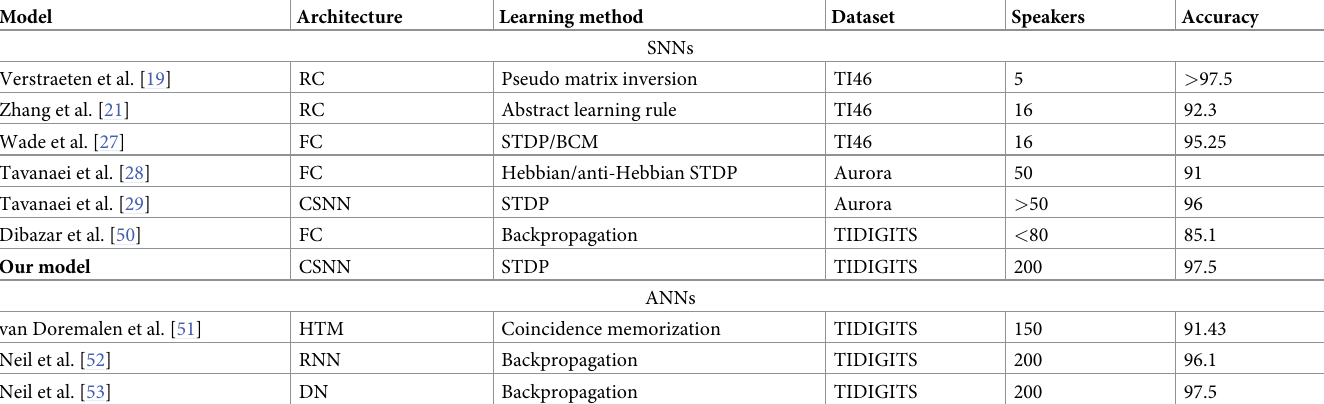
Table 1. Comparison of proposed SNN and other models on the isolated spoken digit classification task. RC: Reservoir computing; FC: Fully-connected layer; CSNN: Convolutional spiking neural network; HTM: Hierarchical temporal memory; RNN: Recurrent neural network; DN: Delta network. Model